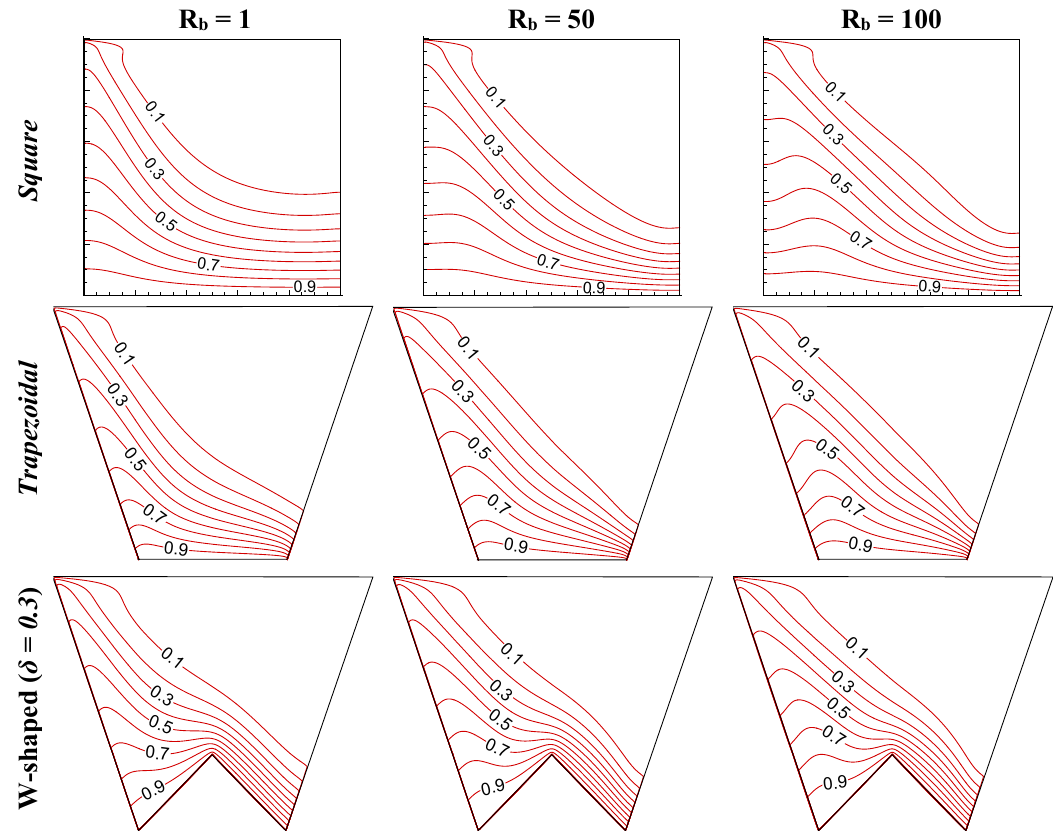
Figure 3. Isotherms contours ( θ ) for different geometric cavity at Le = Pe = 1, Gr = 10 4 , Da = 10 –3 , Ha = 30 for square, trapezoidal and W-shaped